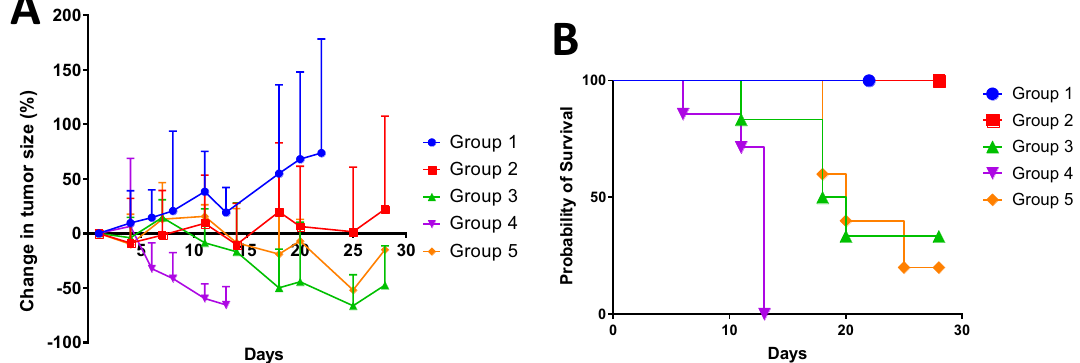
Figure 3. Results of radioimmunotherapy studies with [ 67 Cu]Cu-NOTA-Pertuzumab in 5 groups of mice bearing HER2+ HCC1954 tumors. ( A ) Tumor size changes in percentage with respect to the size prior to treatment (n = 4–7); ( B ) Kaplan–Meier survival curves. Both figures were graphed with GraphPad Prism 7.0 (https ://www.graph pad.com/scien tific -softw are/prism